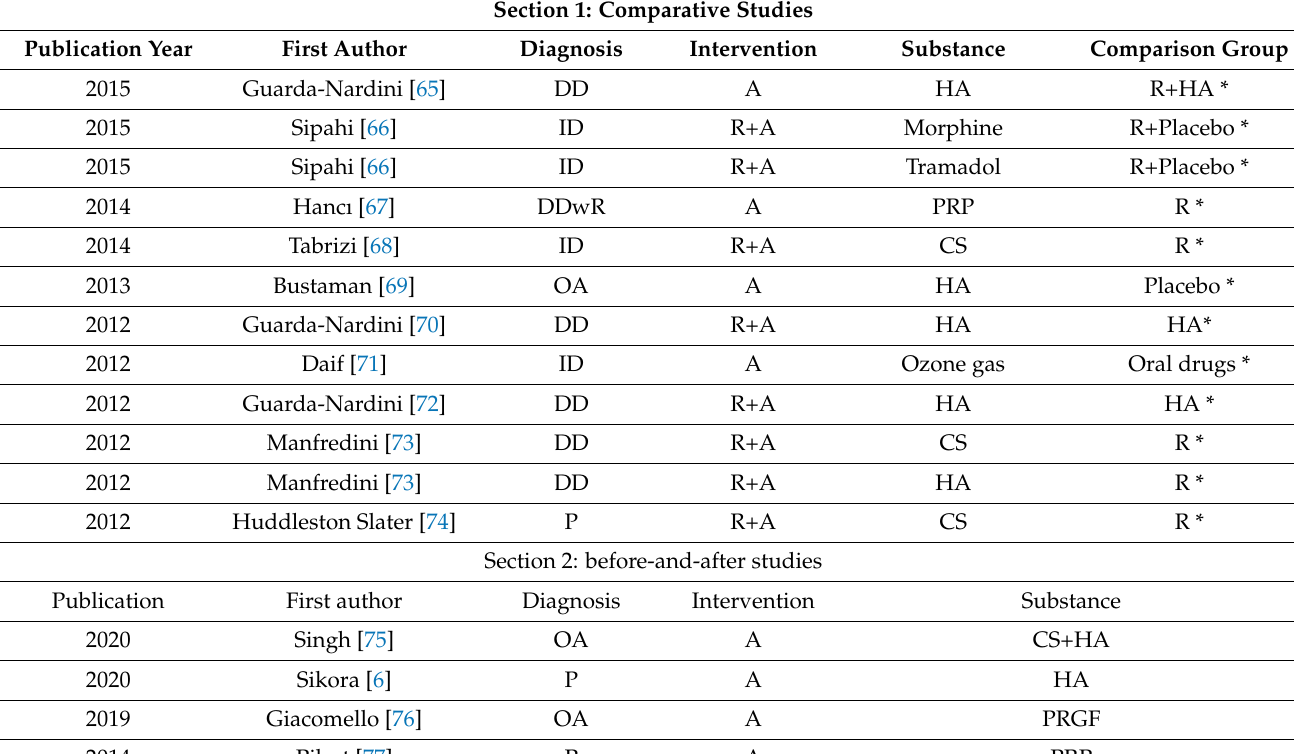
Table 3. Cont. Section 1: Comparative Studies